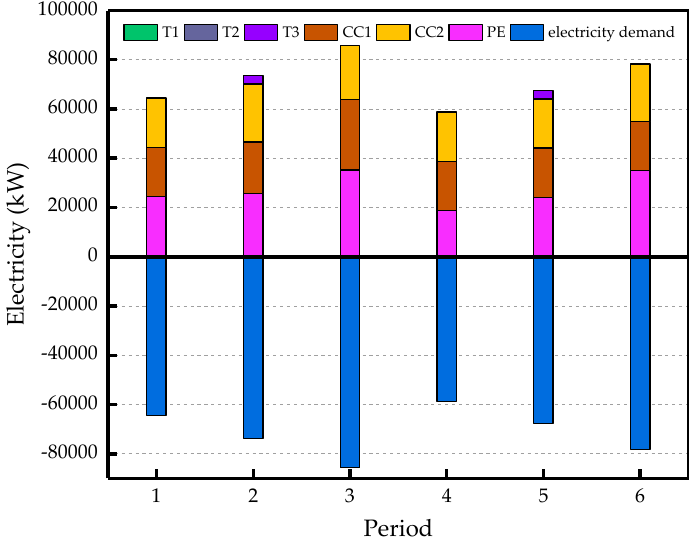
Figure 6. Optimal scheduling results for electricity.